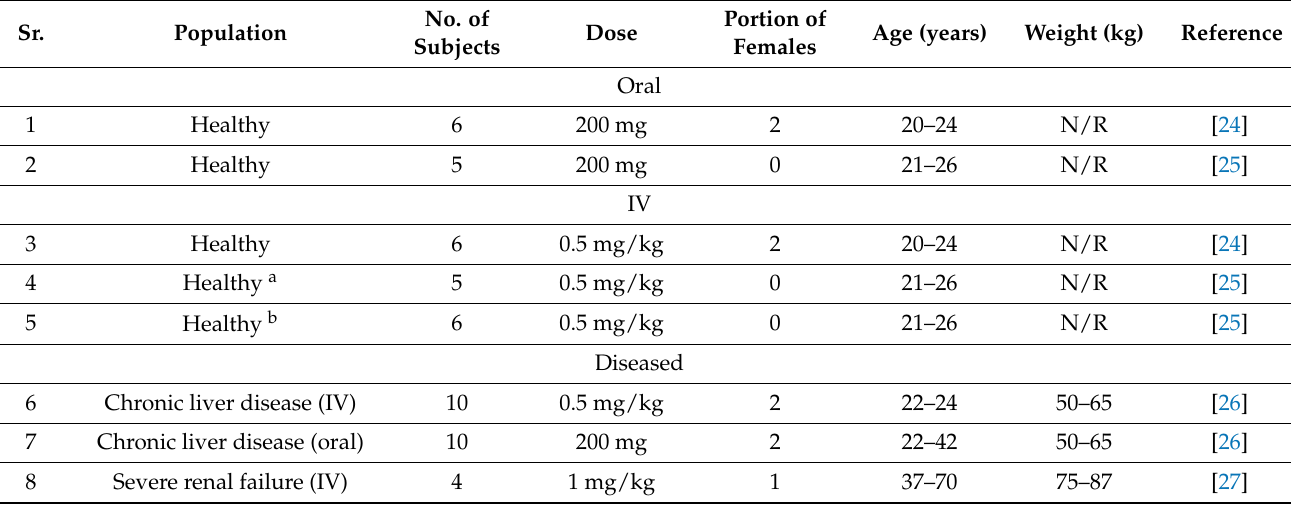
Table 1. Characteristics of the studies selected for PBPK